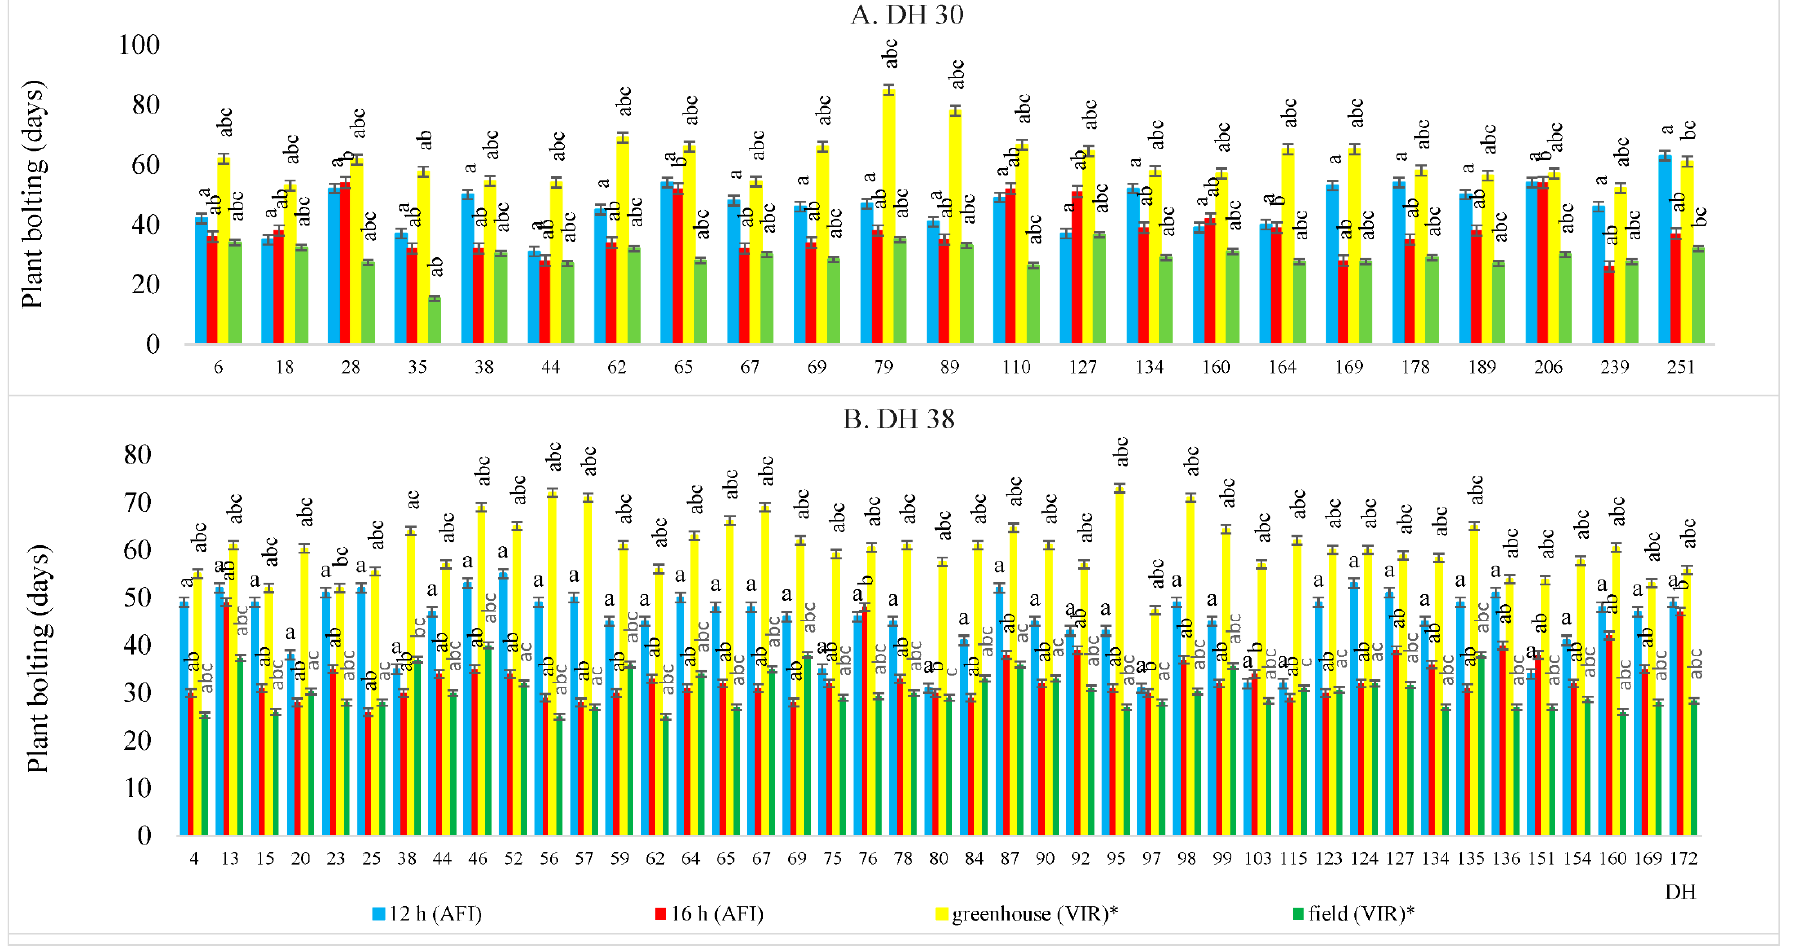
Figure 2. The timing of the start of bolting of lines of mapping populations DH 30 ( A ) and DH 38 ( B ) when grown under different conditions. Note: values with different superscript a–c in the column were significantly different ( p < 0.05). * By Artemyeva et al., 2012 [1].